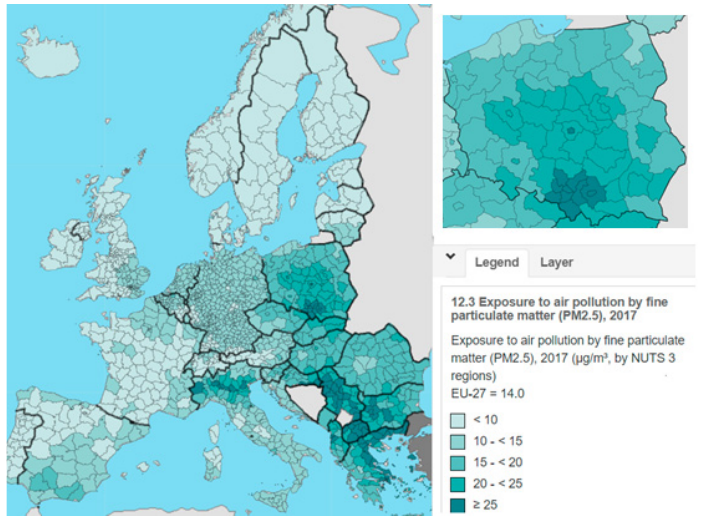
Figure 1. Exposure to air pollution by fine particulate matter PM2.5in EU and in Poland [20].